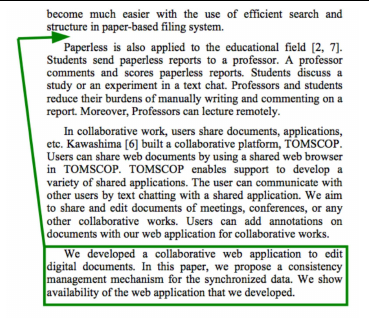
Fig. 9. Paragraph